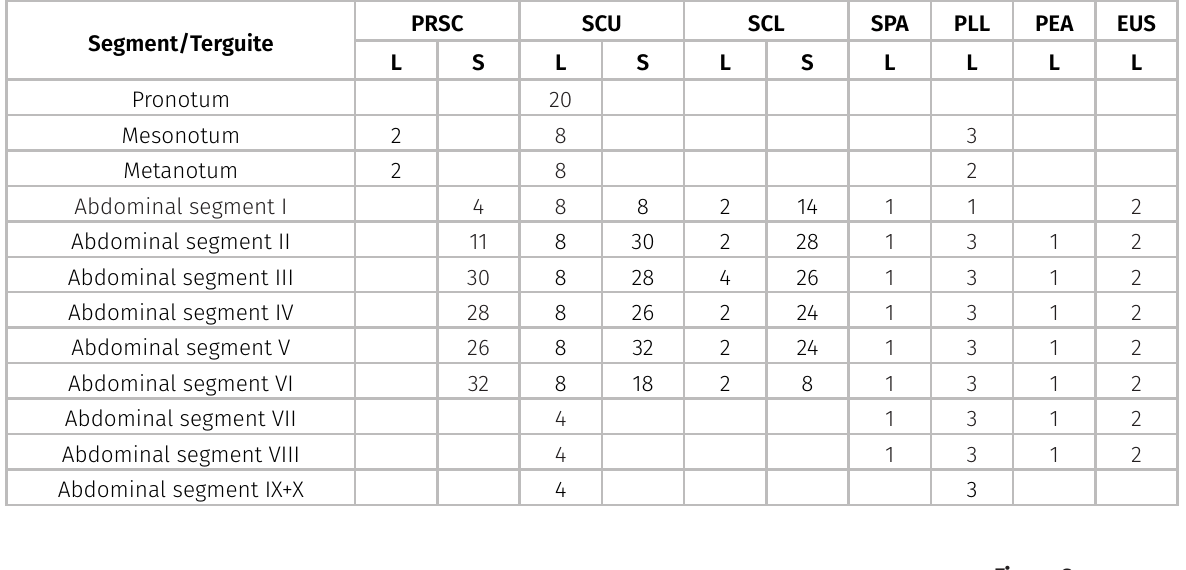
Figure 3. Stenocrates agricola , third instar. (a) Habitus